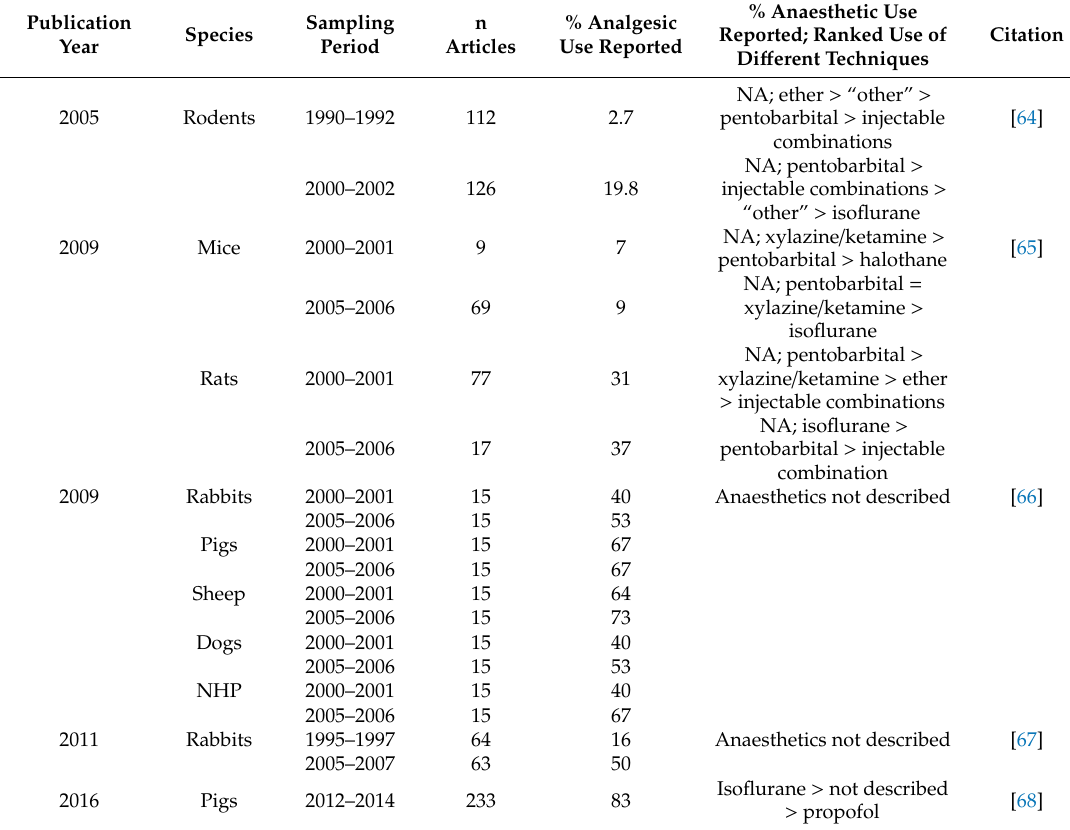
Table 1. The Extent of anaesthetic and analgesic administration in animal experimentations as determined by literature analysis. NA: not